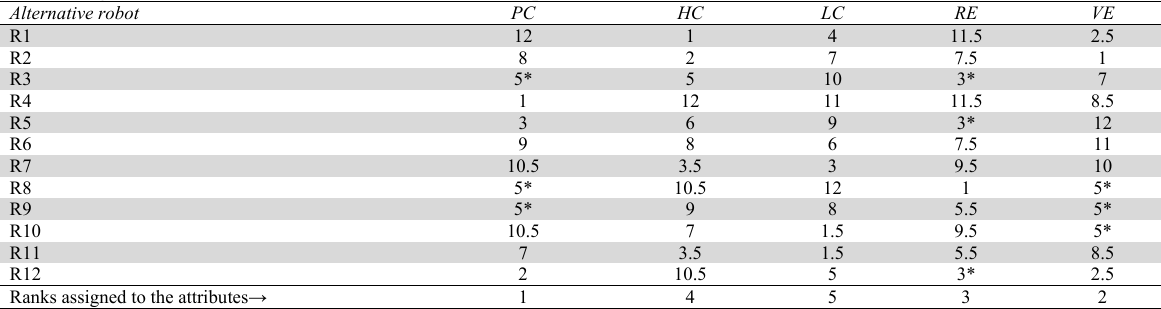
Ranks assigned to the alternatives and attributes of example 2 Alternative